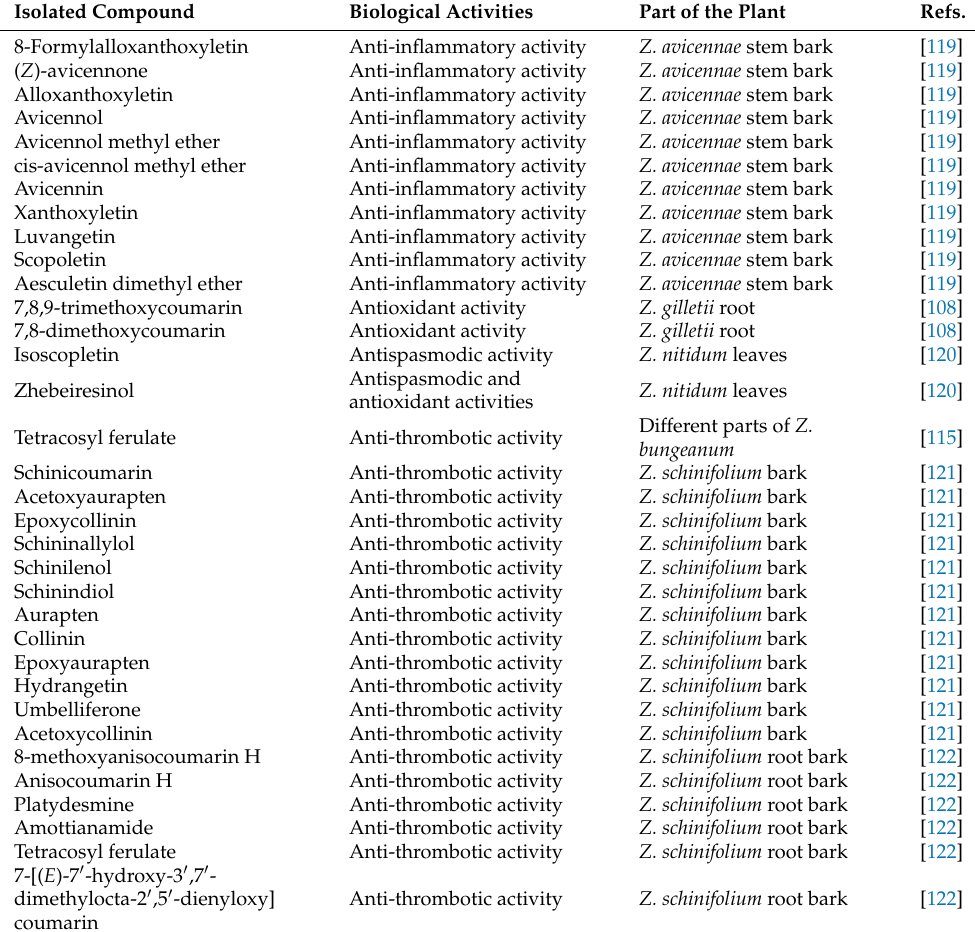
Table 4. Coumarins and their derivatives isolated from Zanthoxylum species with anti-inflammatory, antioxidant, antispasmodic and anti-thrombotic activities.